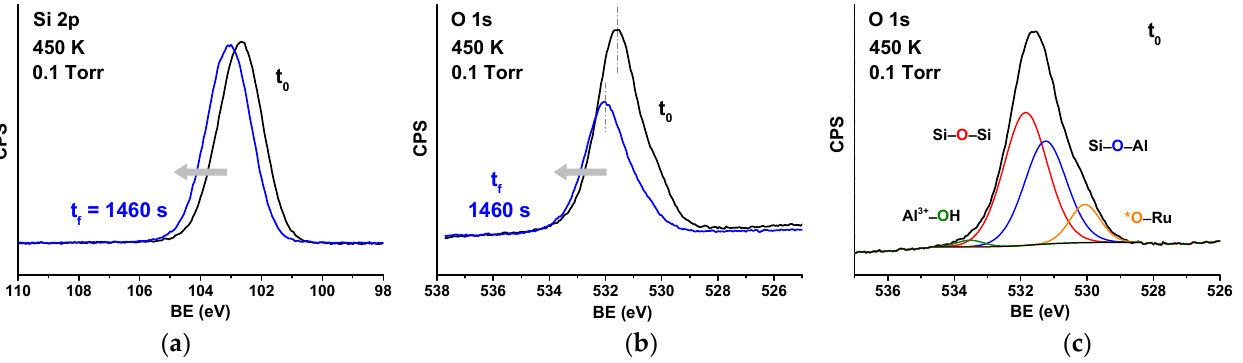
Figure 3. Si 2p ( a ) and O 1s ( b ) core level spectra before and after reaction at 450 K in 0.1 Torr of H 2 ; ( c ) deconvolution of the O 1s core level spectrum before reaction.